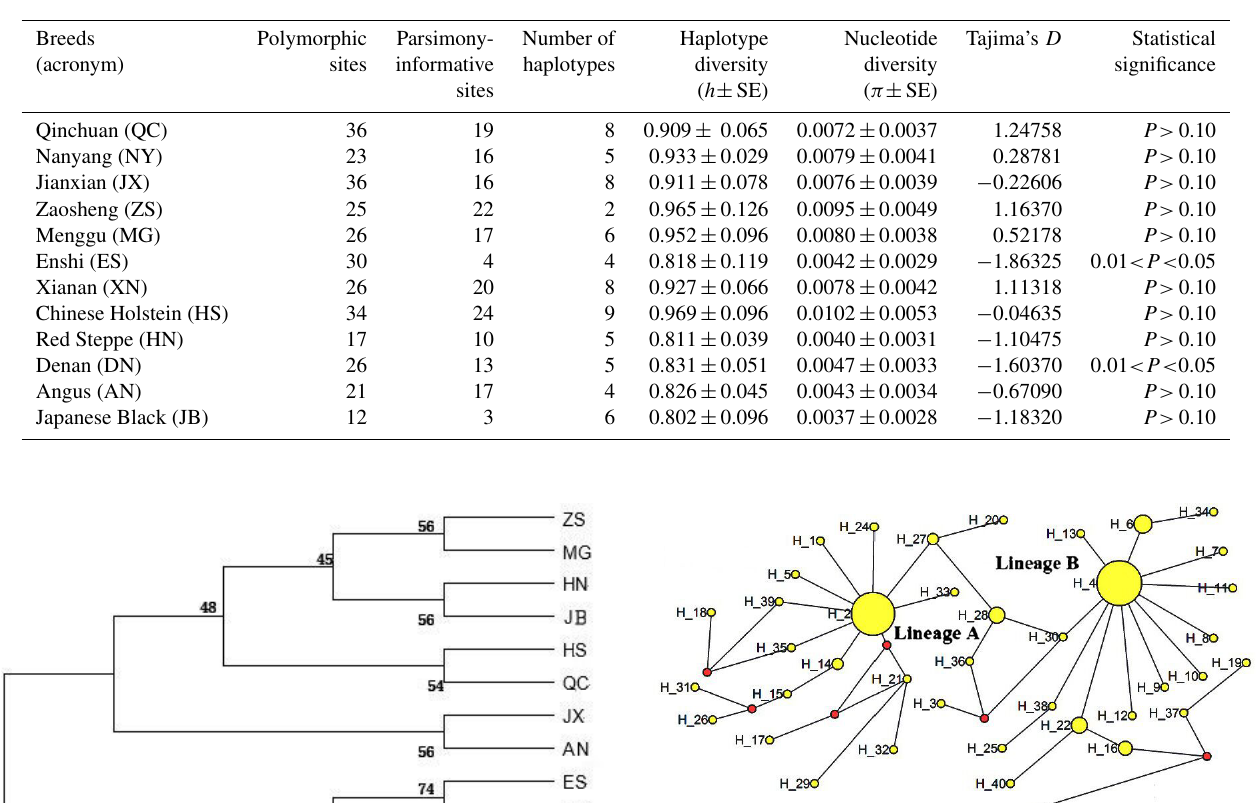
Table 2. Genetic diversity indexes in 10 Chinese cattle breeds and two foreign breeds based on mtDNA 16S rRNA gene sequences.